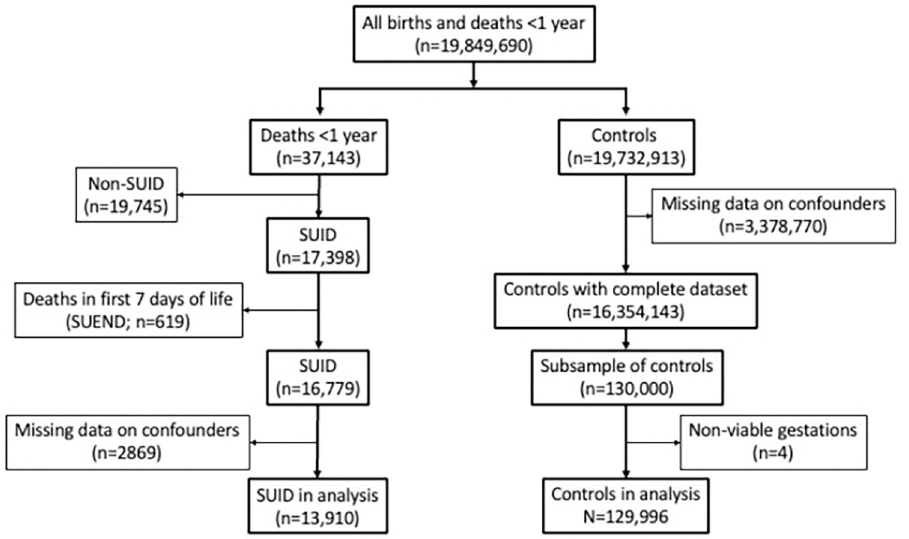
Fig 1. Flow diagram of SUDI cases and controls (infants that lived through to the first birthday and reasons for exclusions.